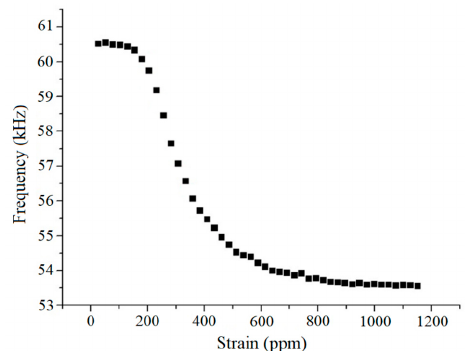
Figure 7. Sensor resonant frequency vs. sample strain for SAE 1010 steel substrate, as calculated from the advance of the testing machine. From [1].